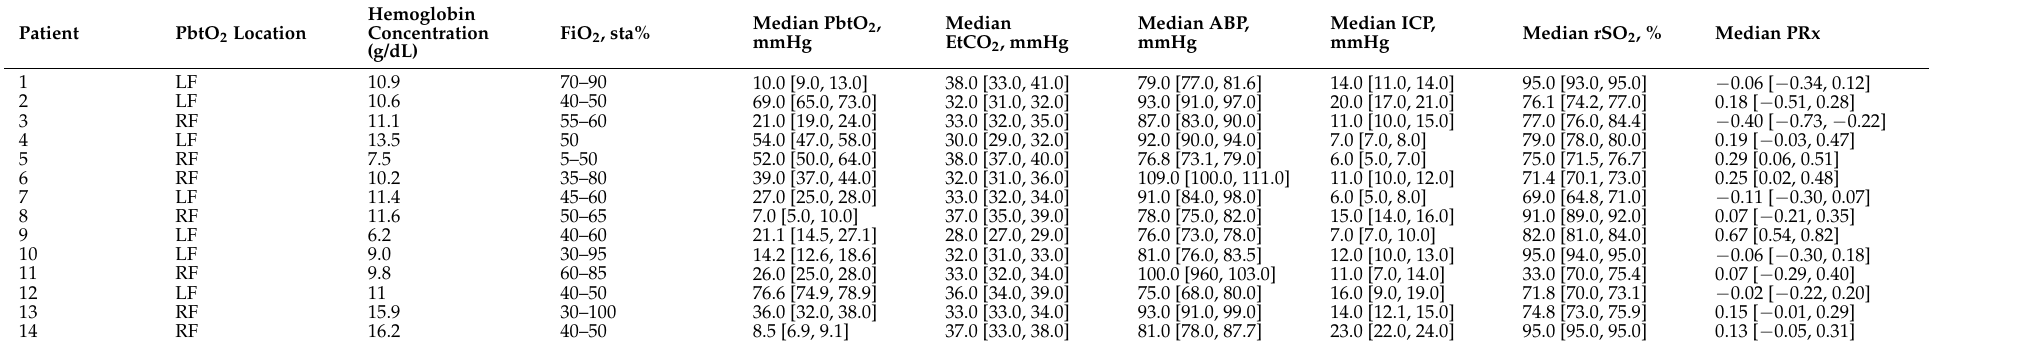
Table 2. Patient PbtO 2 Location, Hemoglobin Concentration, and Physiologic